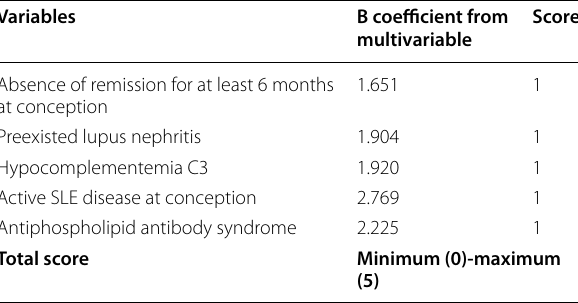
Table 6 The B coefficient from the multivariable logistic regression model and corresponding risk score for predicting adverse pregnancy outcomes in lupus patients